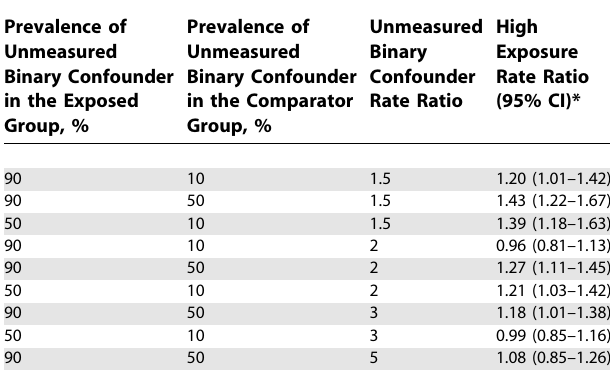
Table. Sensitivity of the Rate Ratio for Cardiovascular